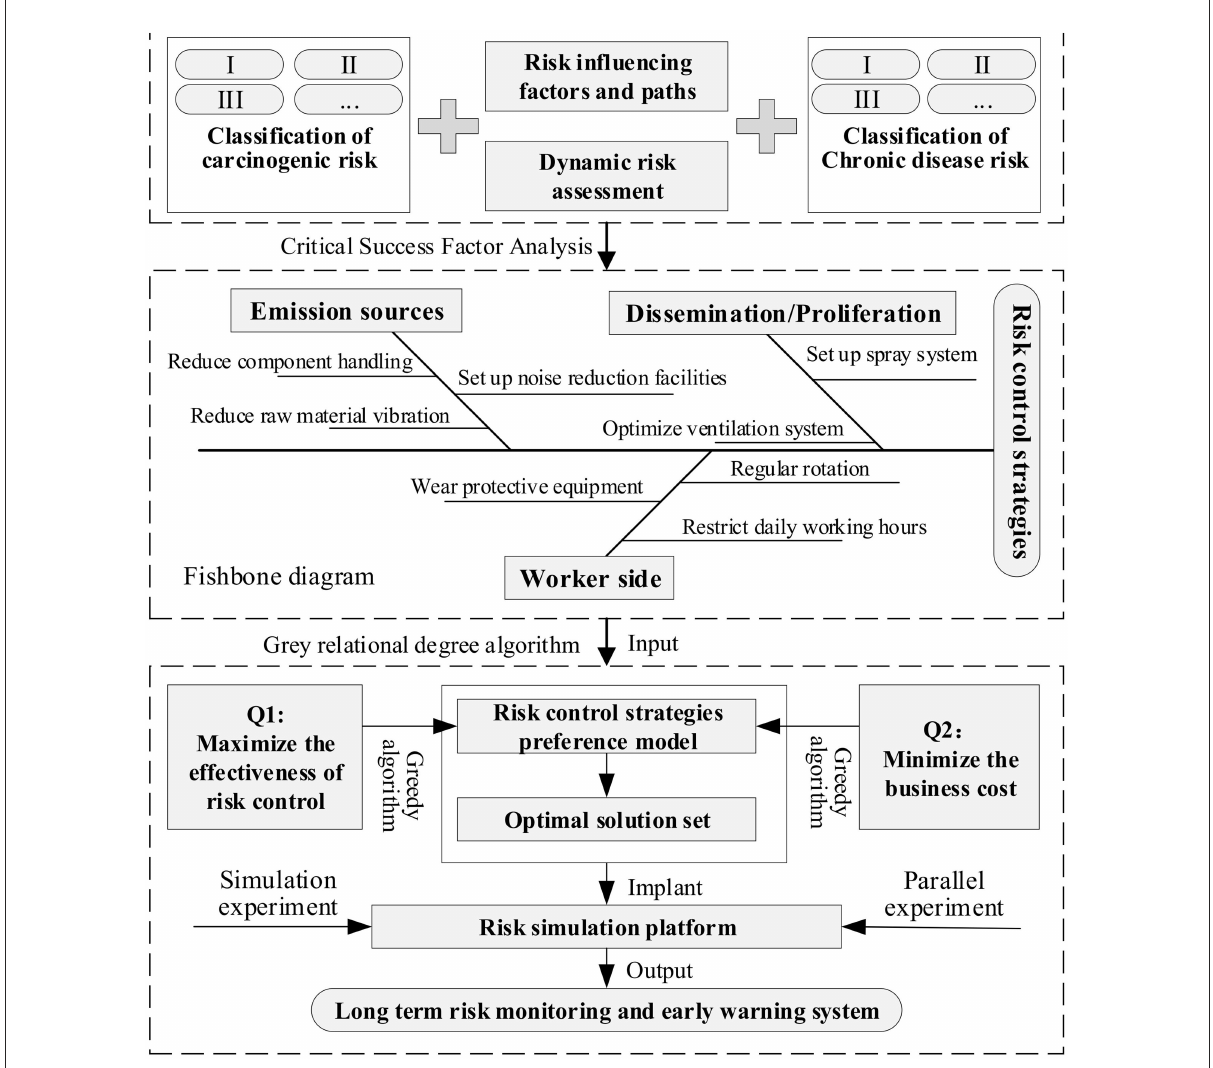
FIGURE6 Long-term control model for occupational health risks caused by environmental